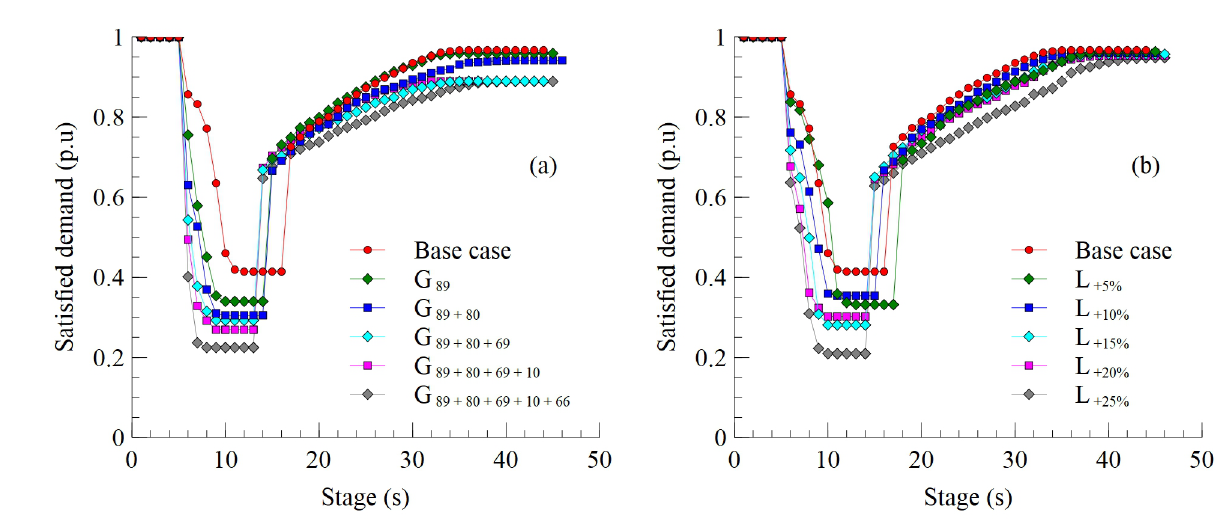
Figure 10. Process of disintegration and recovery of the IEEE-118 bus test system with variations in: ( a ) generation; and ( b )